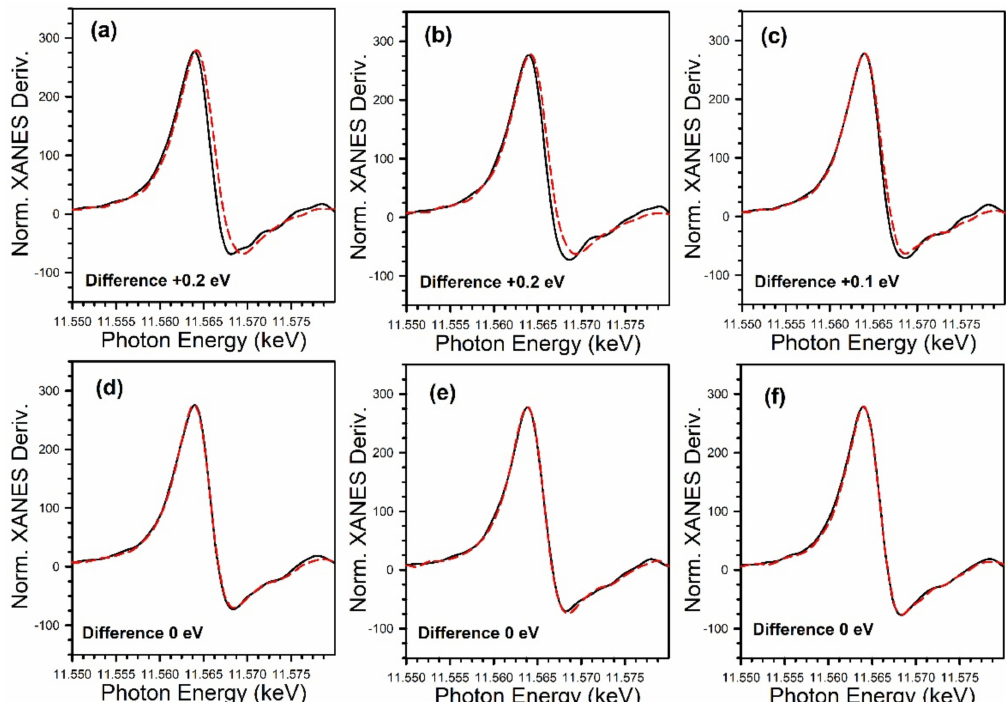
Figure 16. XANES derivative spectra at the Pt L 3 edge of (solid line) the Pt 0 foil and (red line) the catalysts following reduction in pure hydrogen, including 2% Pt/ZrO 2 with: ( a ) 0% K; ( b ) 0.85% K; ( c ) 1.70% K; ( d ) 2.55% K, ( e ) 3.40% K; and ( f ) 4.25% K. No evidence for e - transfer to Pt from K + was found.